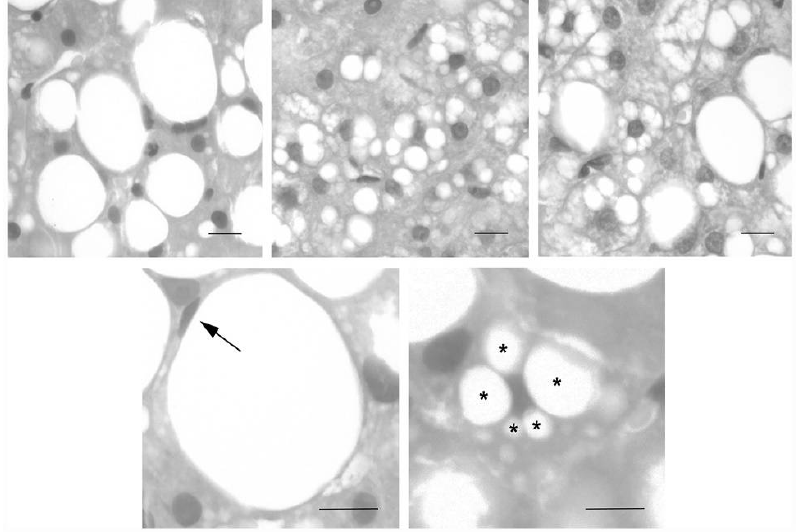
Figure 1. Representative images of liver biopsies performed in the donor regarding macrovesicular steatosis of large (Ld-MaS) and small droplets (Sd-MaS) according to Brunt EM (see [3,4]). In Ld-MaS, a single vacuole of fat larger than half the cell displaces the nucleus to the periphery. In Sd-MaS, the fatty vacuoles are smaller and do not displace the nucleus. Upper panels show hepatocytes with small LD-MaS (left panel) or small Sd-MaS (middle panel) or with both types of macrovesicular steatosis (right panel). The lower panels illustrate a hepatocyte with a single fatty vacuole and a peripheral nucleus (arrow, left panel) and a hepatocyte with multiple fatty vacuoles of different sizes (asterisks) and a centrally located and indented nucleus (right panel). Staining: hematoxylin and eosin. Bars: 20 µ